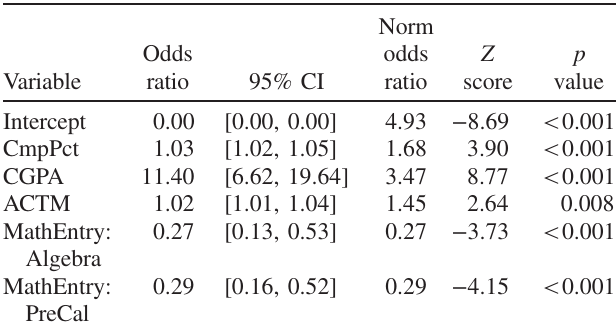
TABLE IV. Physics 1: Optimal institutional logistic